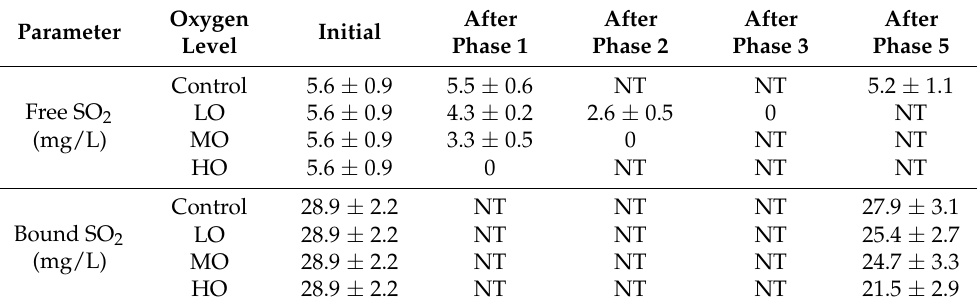
Table 1. Content of free and bound SO 2 of wines treated with different oxygen exposures. Parameter Oxygen Level